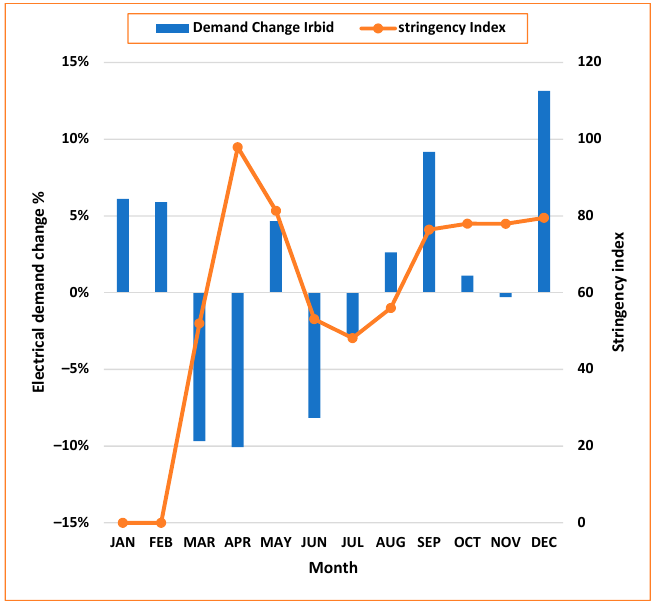
Figure 14. Monthly change in electricity demand between 2019 and 2020 at IDECO‘s area with the variation in stringency index.